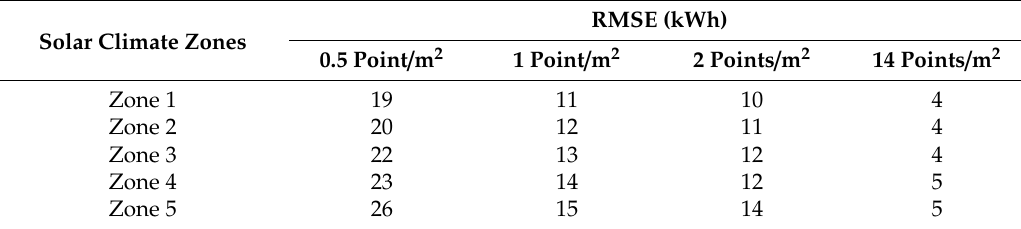
Table 12. Average daily electrical energy loss (kWh) due to the error in the estimation of the rooftop area for di ff erent point cloud densities: industrial buildings with a flat roof of 100 m 2 .